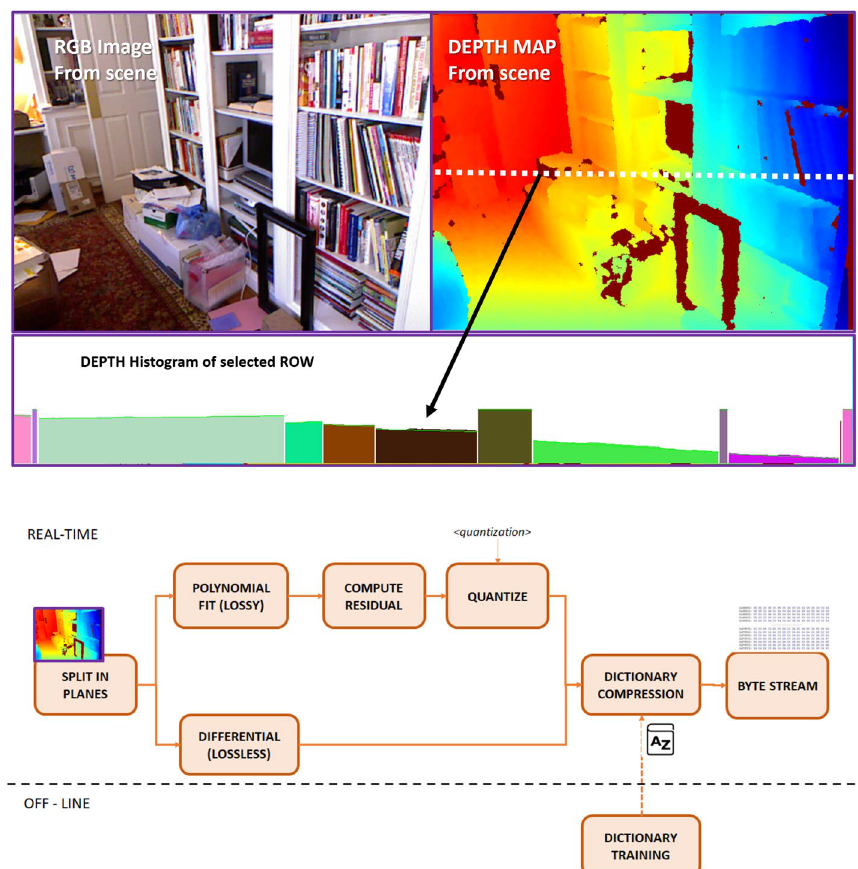
Fig. 2 Encoding pipeline (top). Schematic (bottom) step-by-step